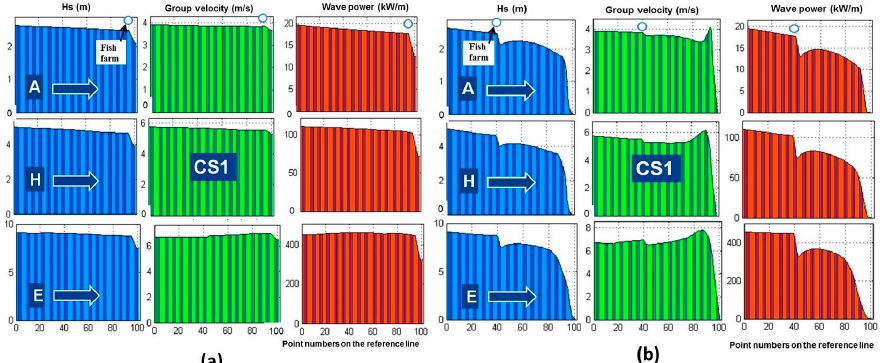
Figure 5. CS1 (no wave farm), results of the SWAN model simulations along the reference lines (RL1 and RL2). The wave parameters represented are: significant wave height—Hs, group velocity— Cg and wave power— P W . The reference lines are divided in 100 points equally spaced. ( a ) Model results along RL1; ( b ) model results along RL2. A—average wave conditions, H—high wave conditions, E—extreme wave conditions. The location of the fish farm is indicated with a white circle in the upper